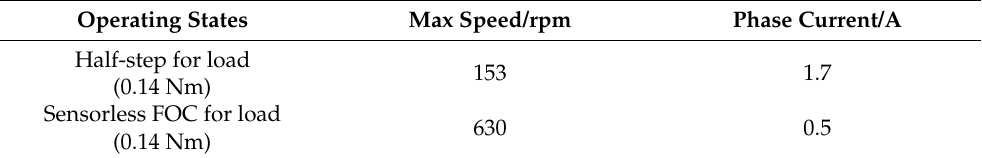
Table 6. The maximum speed in loaded